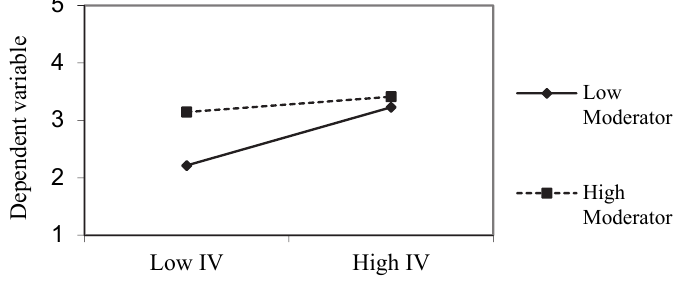
Fig. 3. Moderating effect of knowledge management on the relationship between organisational resilience and company